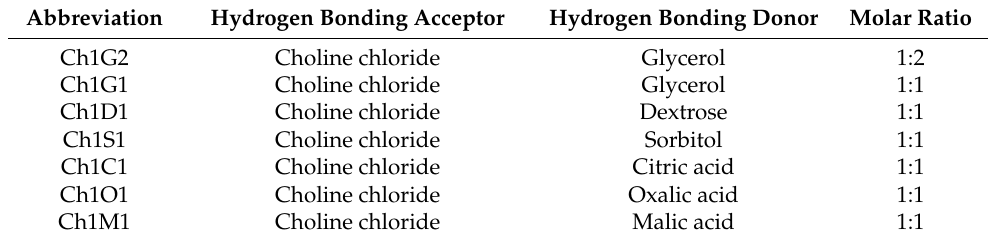
Table 1. Natural deep eutectic solvent